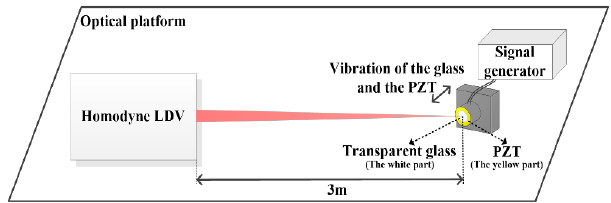
Figure 3. The calibration test setup for the detection capabilities of the LDV.